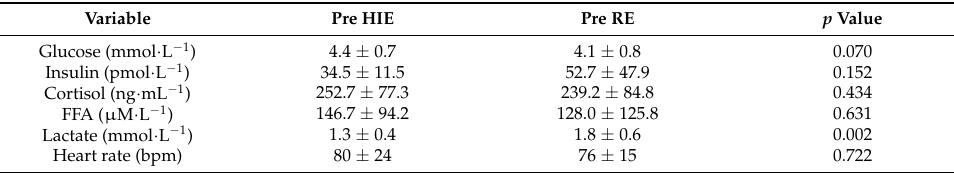
Table 2. Pre-exercise trial physiological variables (Mean ± SD).